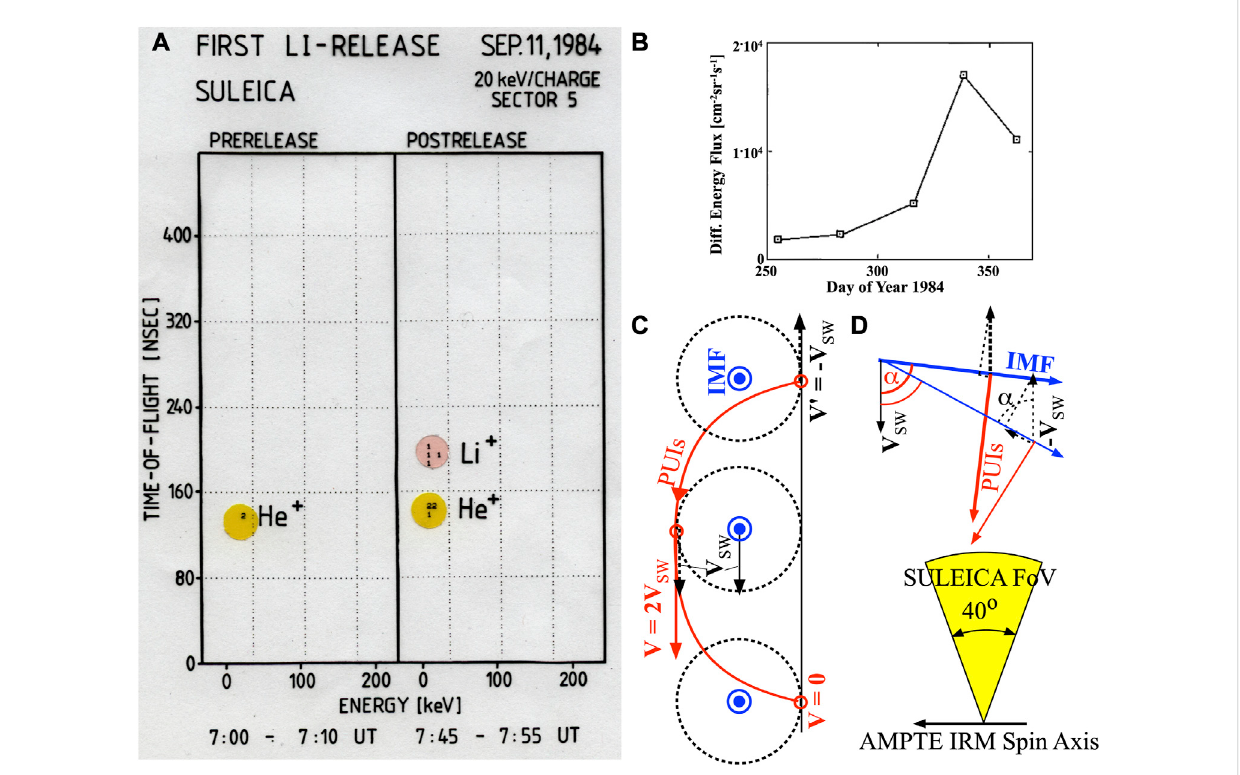
FIGURE 1 (A) Historic TOF versus energy representation of individual He + and Li + PUIs detected before and after the fi rst AMPTE Li release. (B) He + PUI fl ux obtainedwithAMPTESULEICAasafunctionofdayoftheyearin1984.The fl uxreachesamaximuminearlyDecemberwhentheEarthisdownwindofthe Sunrelativeto theISNgas fl owthroughthesolarsystem[adaptedfrom(Möbiusetal.,1985b)],reproducedwithpermissionfromSpringerNature.AMPTE IRM was in the SW only from September through January, hence the clipped coverage of PUIs. (C) PUI motion in theplaneperpendicular to the IMF (the blue circular symbol), gyrating about the IMF in the SW frame (the dashed black line), and moving on a cycloid in the spacecraft frame (the solid red line). After ionization from neutral gas at rest, a PUI (the open red circle) starts with V = 0 in therest frame, while it is injected into the SW with V ’ = -V SW in the SW frame. Therefore, the PUI gyrates about the IMF with the speed V SW (the dashed black circle). In the rest frame, this gyration is seen as a cycloid trajectory, which starts with V = 0, reaches a maximum speed of 2 V SW or cut-off at the top, where the PUI speed in the SW frame adds to the SW speed, andcompletesoneturnagainwith V =0.Thismotionissimilartothatofavalveofabicyclewheel,asseenbyanobserveratrest.ItdistinguishesPUIsfrom themotionandenergydistributionofSWions.ScatteringofPUIsintheirpitchangle α (see1D)at fl uctuationsintheIMFbringPUIstothecut-offforallIMF angles. Continuous PUI productionfrom theSun to theobserver and adiabatic coolingin theexpanding SW fi lls thevelocity space between 2 V sw and the SW itself. An introduction to PUIs may be found in a recent text book (Hsieh and Möbius, 2022) and review (Zirnstein et al., 2022) and presents a full overviewonPUIsintheheliosphere. (D) PUImotionintheSW-IMFplane,alongwiththeAMPTESULEICAFoV.IftheIMFisatanangle α < 90 ° relativetothe SW, PUIs are injected into the SW at pitch angle α , resulting in a velocity component parallel to the IMF, which leads to an overall transport of PUIs in the rest frame at angle α relative to theIMF. Shown are sample directions of the PUI motionfor IMF orientations that, after initial pickup, lead theions into the FoV (solid line, α > 70 ° ) or miss the FoV (dashed line, α < 70 °